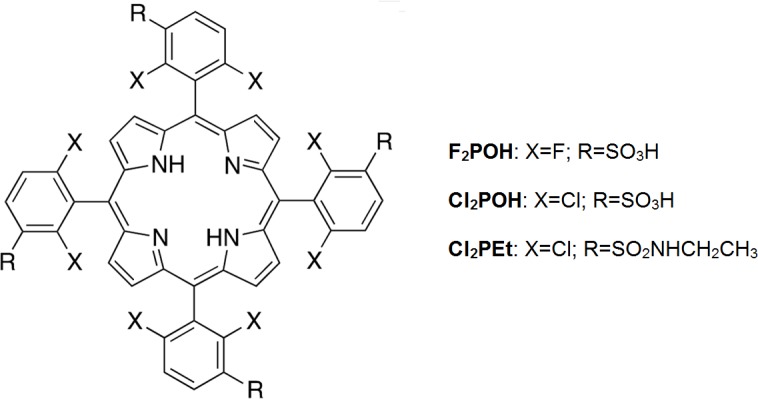
Chemical structures of investigated photosensitizers.